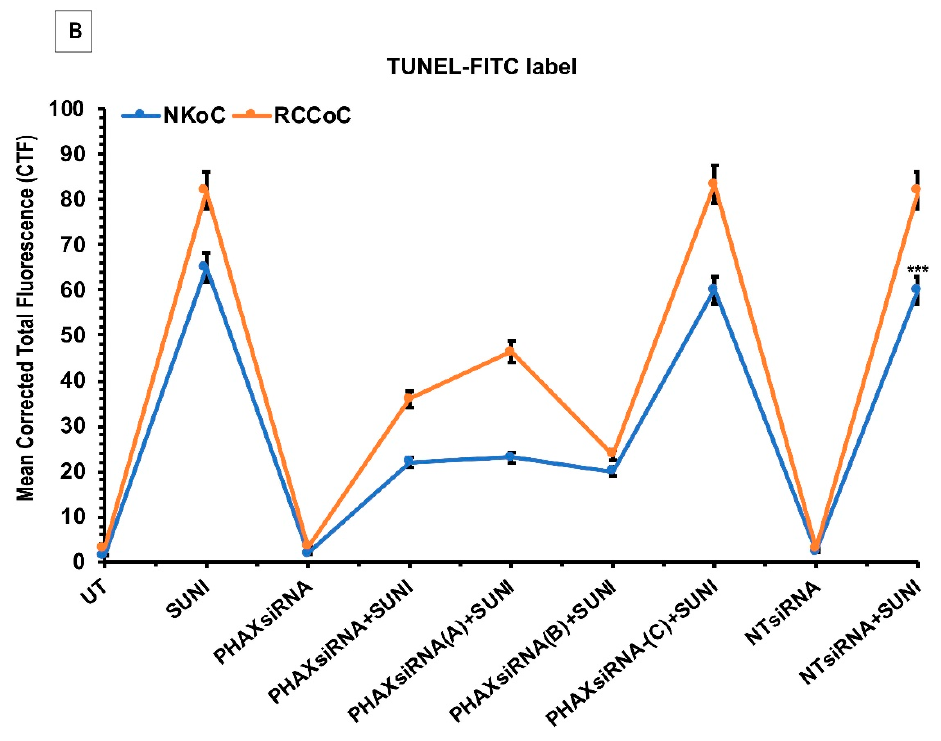
Figure 7. TUNEL positive cells in sections of ccRCC organ cultures subjected to PHAX-siRNA; PHAX-siRNA-A, B, and C; and non-targeting-siRNA (NT-siRNA) prior to treatment with sunitinib (200 µ M) for 1 h at 37 ◦ C. ( A ) Untreated cultures and cultures treated with a cocktail of PHAXsiRNA alone show negligible levels of TUNEL positive cells ( arrows ) (panels a , b ) compared sunitinib-treated cultures, which show increased cell death in some tumour cells (arrowheads) and in CD31 positive blood vessel ECs (arrows) ( c ). In contrast, cultures pre-treated with PHAXsiRNA prior to sunitinib treatment show diminished levels of TUNEL positive cells ( d ), while cultures pre-treated with PHAXsIRNA-C prior to sunitinib treatment showed a similar pattern to cultures treated with sunitinib-alone ( e ). Cultures pre-treated with NTsiRNA (negative control) showed a negligible level of staining, similarly to UT cultures ( f ). Original magnification × 40. ( B ). Quantification of the percentage of TUNEL positive cells / total number of cells x100 at × 40 magnification. Statistical significant data are presented as means + SEMs. (*** p < 0.0001-UT vs. treated cultures); ns–not significant. One-way ANOVA and Bonferroni post hoc test were used to determine statistical significance. *** p < 0.0001—vs. UT or PHAXsiRNA or